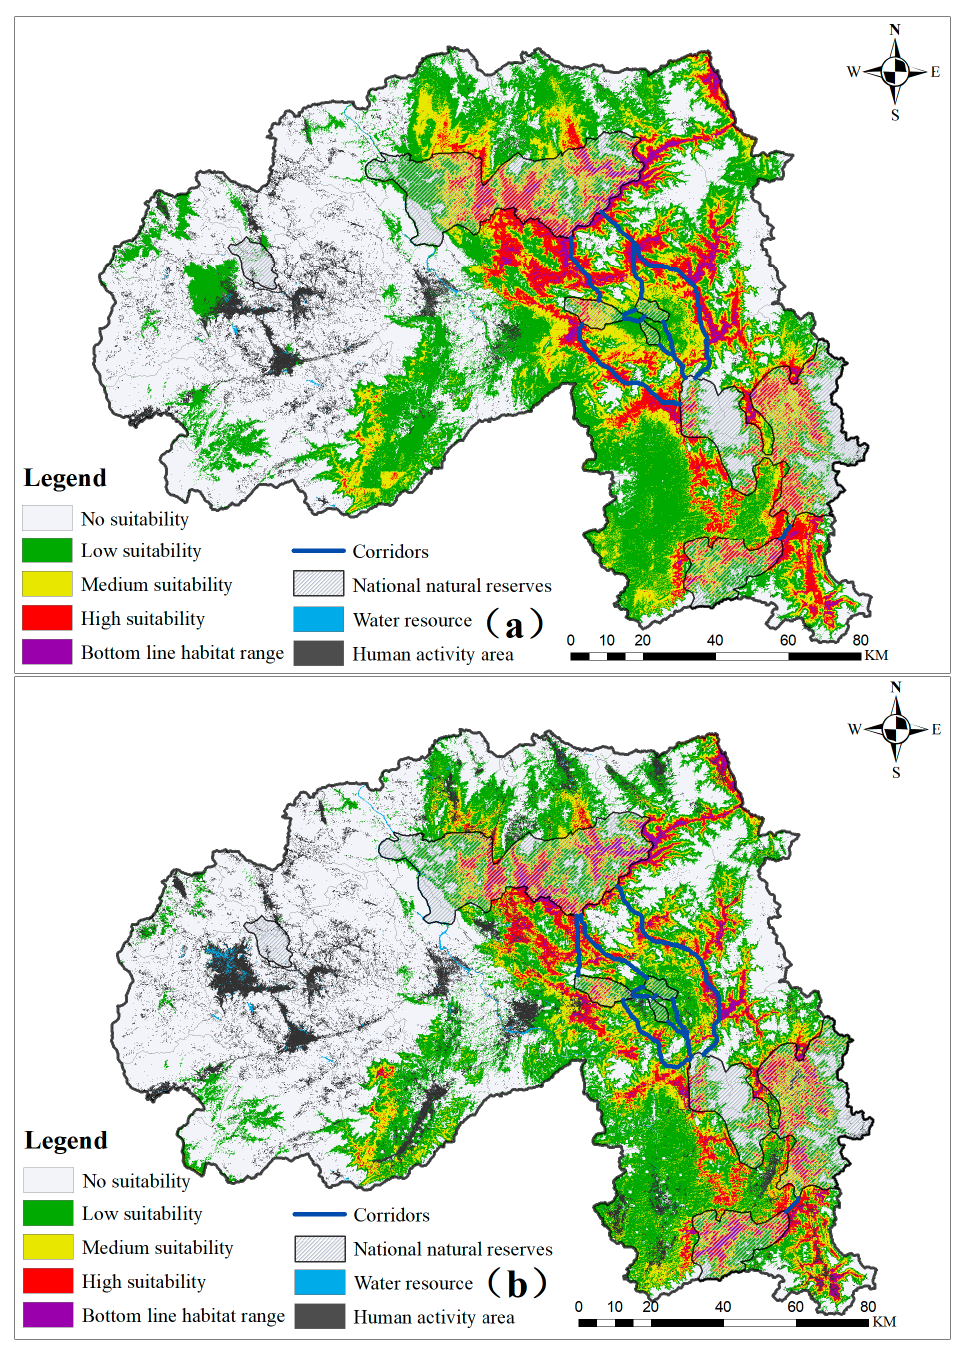
Figure 6. Distribution of Asian elephants in suitable areas in Sipsongpanna under current climatic conditions (( a ) NAI: Non-anthropogenic Interference, ( b ) AI: Anthropogenic Interference).